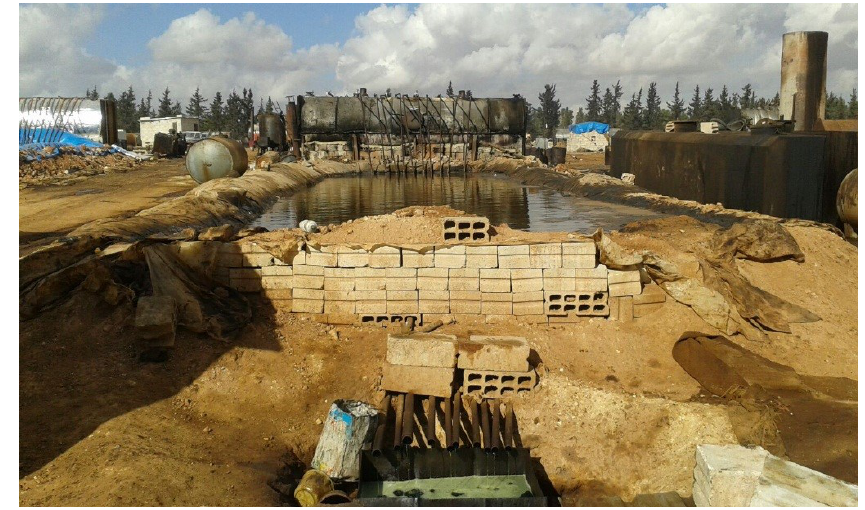
Figure 7. The primitive metal kilns to refine crude oil from Manbij (province Aleppo) into a pit where it will be distilled.